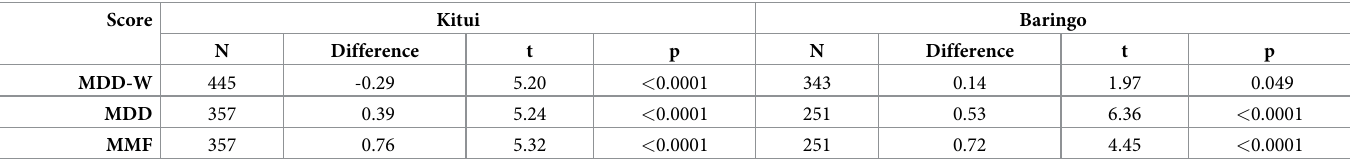
Mean paired difference in respondent scores, CATI Score minus F2F Score. For MDD-W and MDD, units are food groups. Units for MMF are meals per day. All tests are two-tailed paired